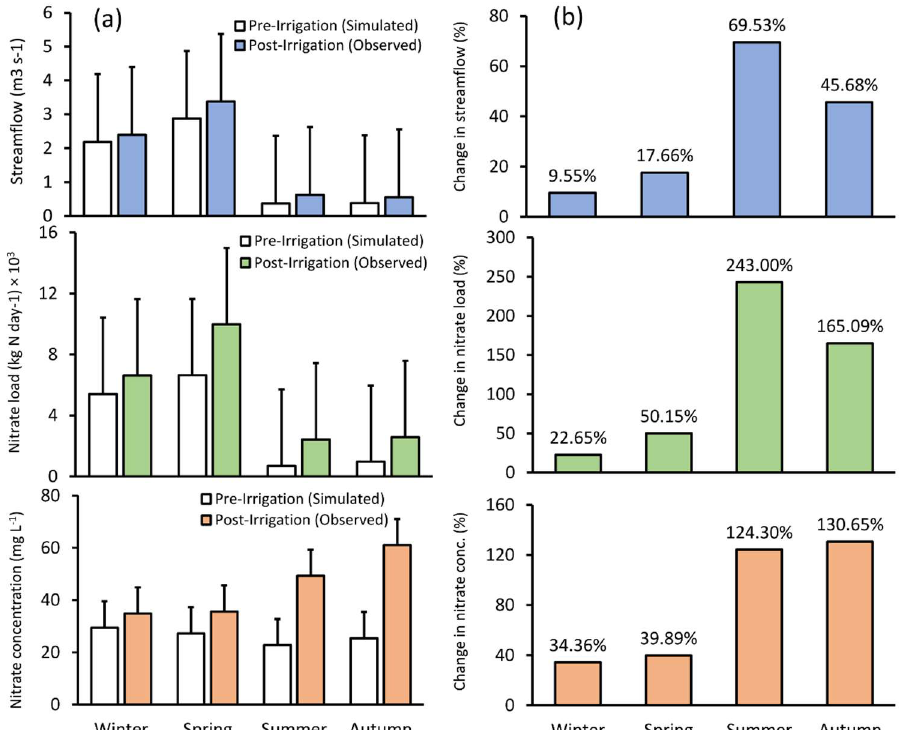
Figure 7. Seasonal comparison of ( a ) pre-irrigation and post-irrigation results and ( b ) the percentage changes after irrigation implementation for streamflow, nitrate load, and concentration at the Traibuenas gauging stations from mid-2017 to 2020.